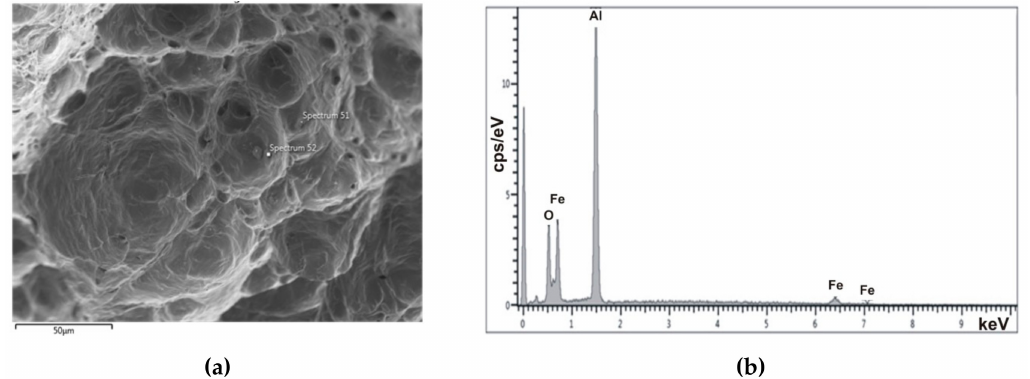
Figure 13. ( a ) Fracture of sample Z6, CT900-2 ◦ , N f = 195.5, T d = 850 ◦ C; ( b ) EDX spectrum from particle in Figure 12a-Fe, O,